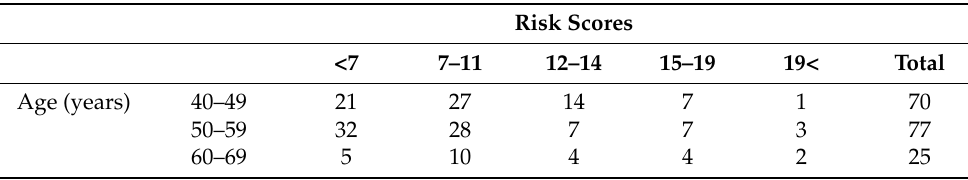
Table 3. FINDRISC distribution stratified based on